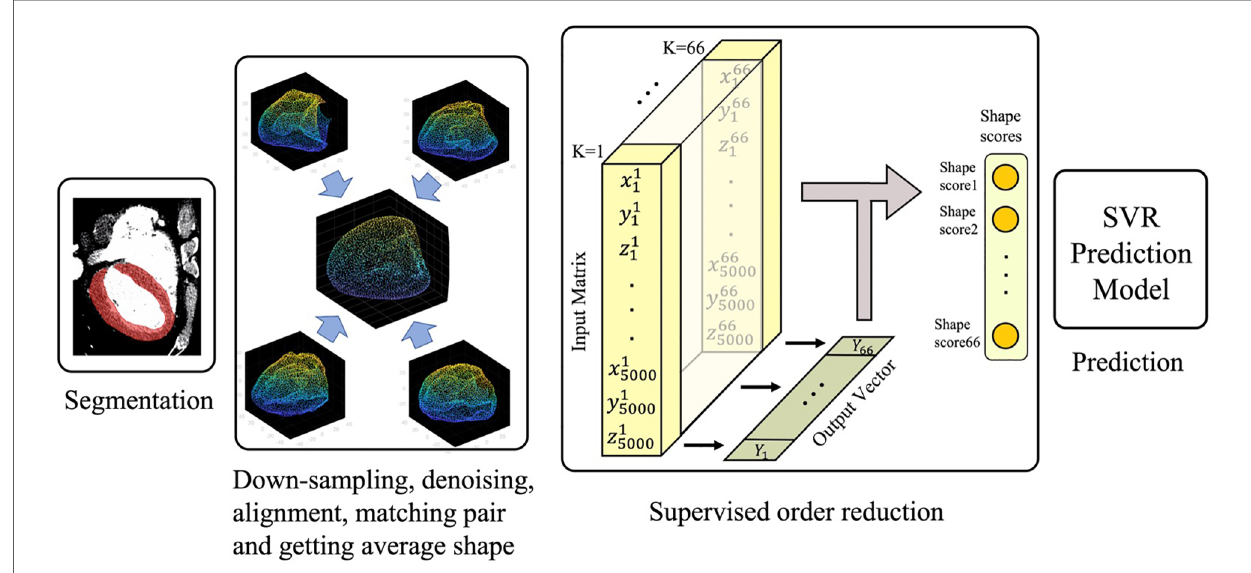
FIGURE 1 Schematic of the statistical shape analysis pipeline used for the outcome